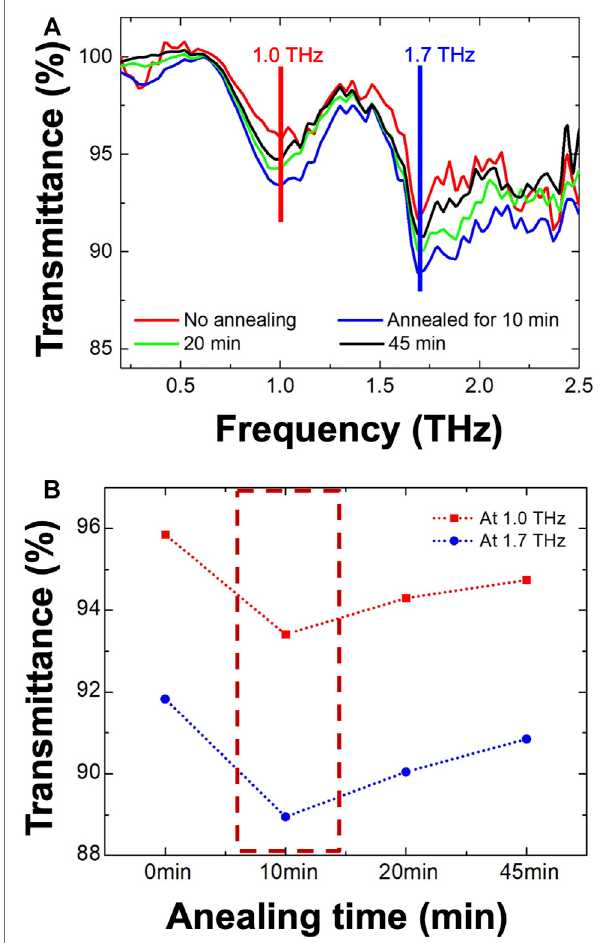
FIGURE 5 | (A) Major THz-wave absorptions are measured at 1.0 and 1.7 THz for each annealed sample. Interestingly, (B) the 10-min annealing sample shows the maximum transmittance with 93.5 and 89% at 1.0 and 1.7 THz,